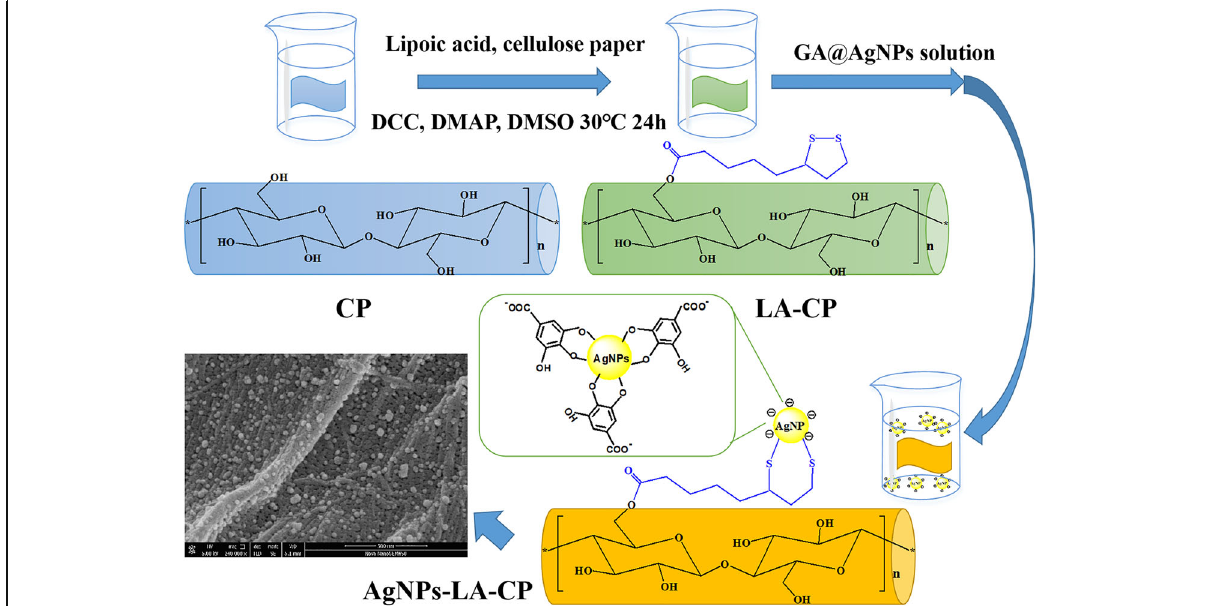
Fig. 1 Schematic illustration of the fabrication process of